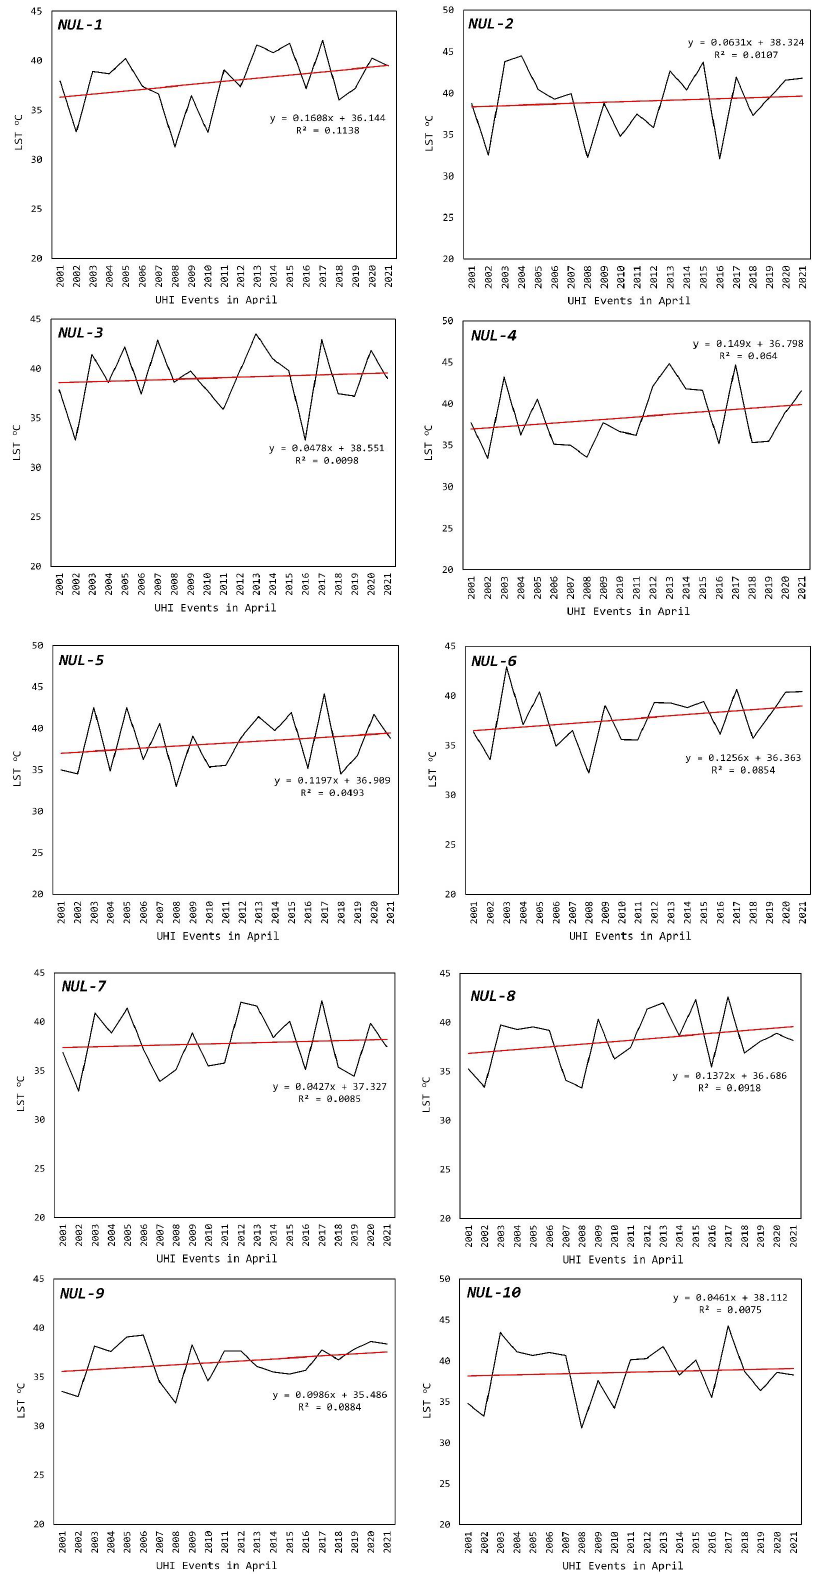
Figure 9. Trend analysis of the UHI events of the selected ten non-urban locations ( NUL ) in the month of April from 2001 to 2021.